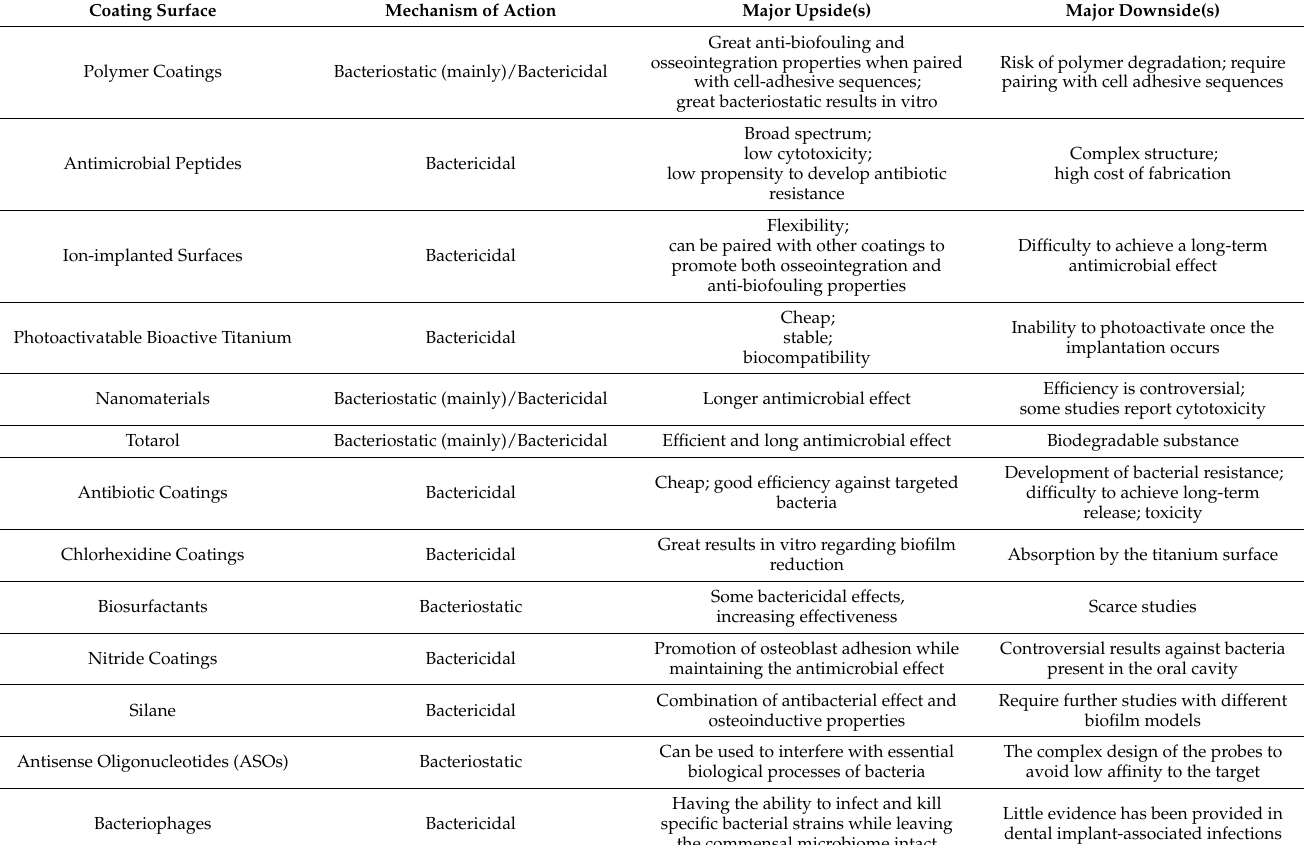
Table 2. Synthesis of the gathered